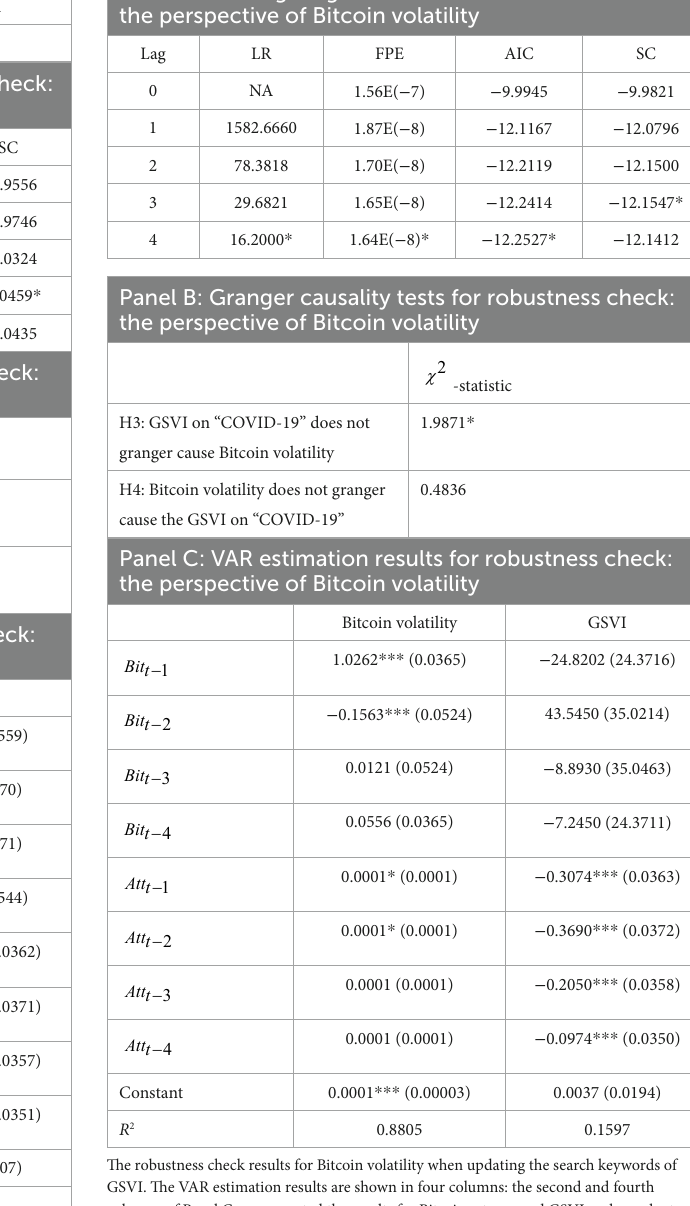
TABLE 6 Bitcoin returns robustness check: updating the search keyword. Panel A: Stationary test for GSVI on “COVID-19”